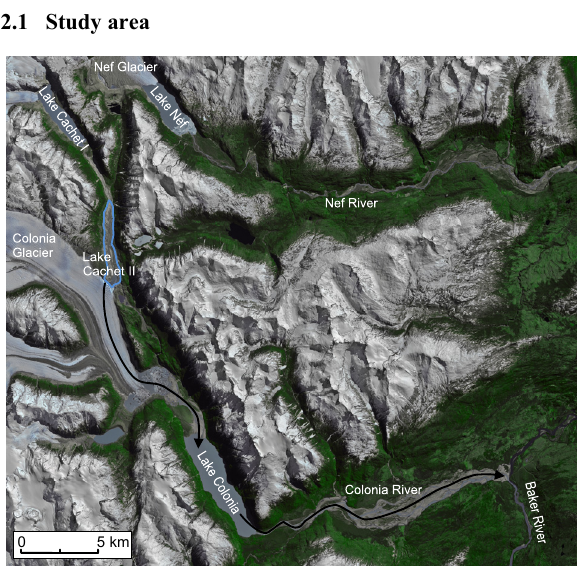
Figure 1. Satellite image (Sept. 2013) of the drained Lago Cachet II and its drainage path to Baker River